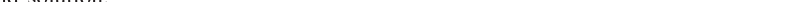
TABLE VII. Double straw question and solution. When you drink with two straws (one in and one out of water) no liquid comes up the straw. Why? Possible normative response: By inhaling we create a partial vacuum at the top of the straw. This results in a pressure gradient in both straws, and a net force upward (even though gravity is acting downward), and an upward acceleration. The pressure gradient is the same on the water and the air, the net upward force on the air is greater (due to smaller weight acting downward), and because air in the straw is lighter than the water in the straw it will accelerate faster and will make it up the straw before the water. This then makes the pressure in the mouth equal to atmospheric pressure, there is no more pressure gradient, no net force upward, no acceleration, and no motion of the water